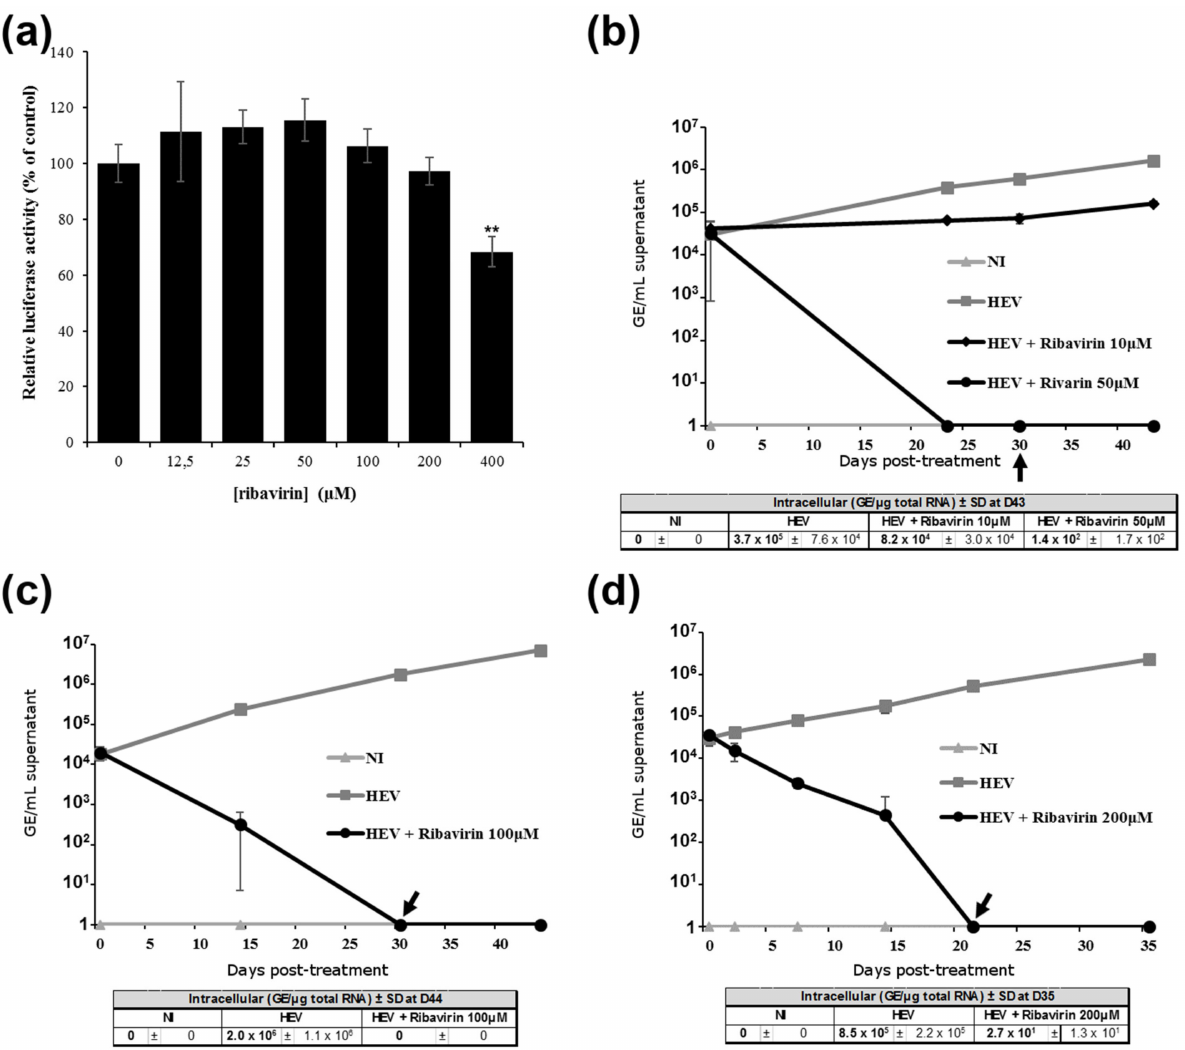
Figure 3. Inhibition of HEV replication by ribavirin. ( a ) Ribavirin cytotoxicity on differentiated HepaRG cells. Differentiated HepaRG were incubated for 12 days with up to 400 µ M of ribavirin. Cells were then lysed and cell viability determined using a luminescent-based assay. Luciferase activities are expressed as percentage relative to non-treated cells. Mean of triplicate samples ( ± standard deviations). **, p < 0.005 compared to untreated cells (unpaired t -tests). ( b–d ) Effect of ribavirin on HEV genome release in the supernatants of differentiated HepaRG cells infected with HEV. Cells were infected for 12 to 13 days with HEV (faecal suspension) at a MOI of 2 before addition of 10 ( b ), 50 ( b ), 100 ( c ) or 200 ( d ) µ M of ribavirin. Addition of drugs was stopped 21 ( d ) to 30 ( b , c ) days post-treatment as indicated by a black arrow. The HEV genome present in the supernatants of HepaRG cells was quantified using RT-qPCR at different days post-treatment. Tables show HEV concentrations in the intracellular compartments at the end of the experiment. Mean of triplicate samples ( ± standard deviations (SD)) are shown. NI = non-infected; D =